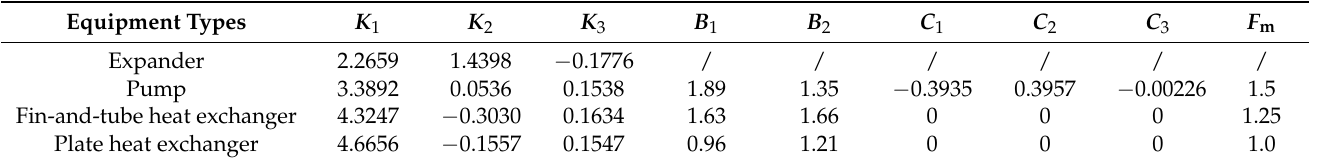
Table 5. Main parameters of economic model